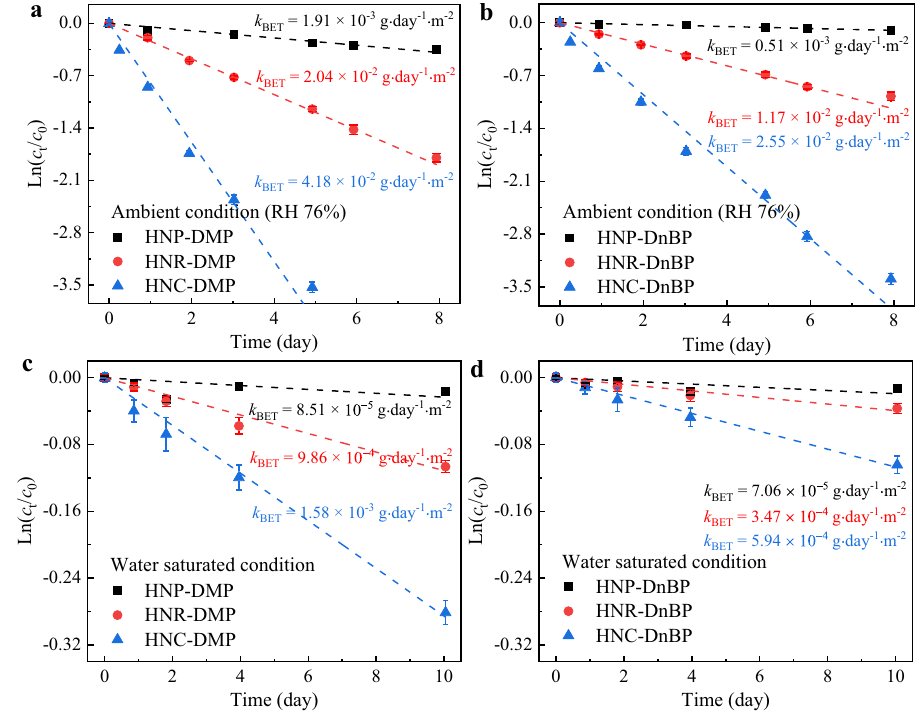
Fig. 2 | Hydrolysis kinetics. The fi tted fi rst-order kinetics of dimethyl phthalate (DMP) ( a , c ) and di- n -butyl phthalate (DnBP) ( b , d ) on hematite nanoplate (HNP), hematite nano-rhombohedra (HNR), and hematite nano-cube (HNC) under the ambient condition of RH 76% ( a , b ), and the water-oversaturated condition ( c , d ),